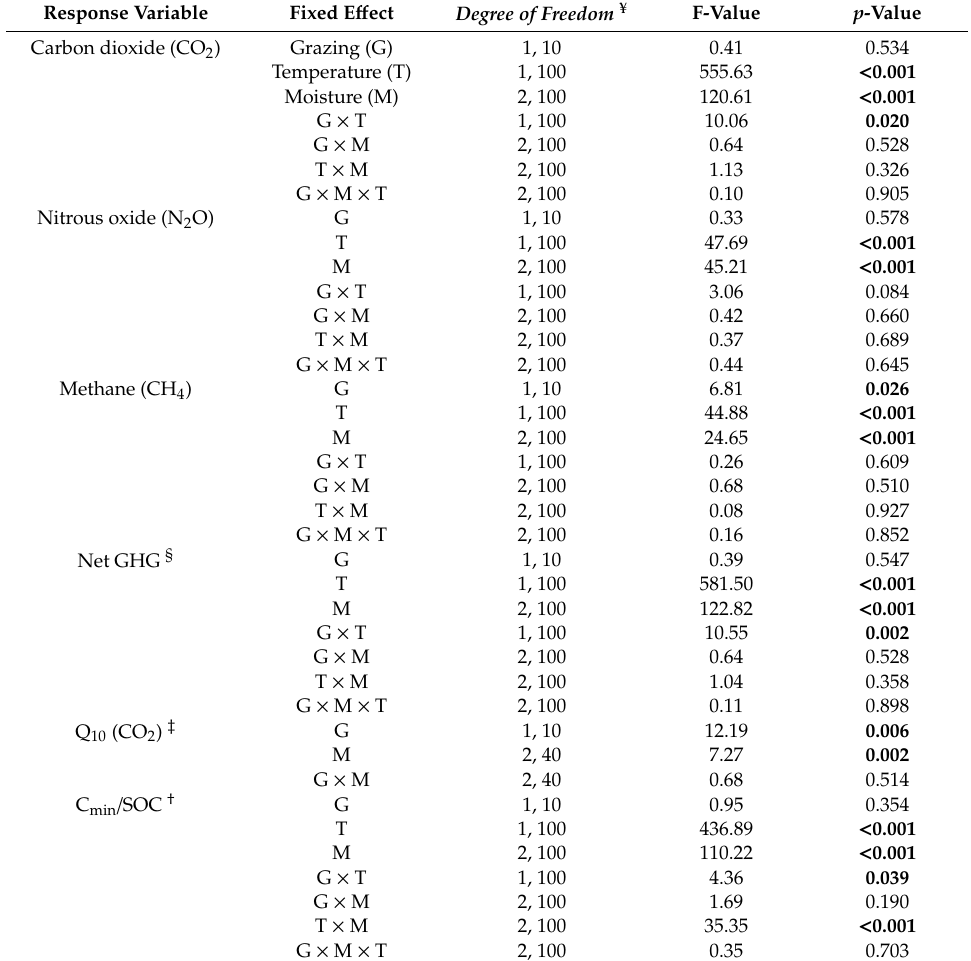
Table 1. Summary of ANOVA, degree of freedom, F- and p - values for the cumulative flux of greenhouse gases (GHGs) during the 102-day long incubation period. p -values in bold are ≤ 0.05. Response